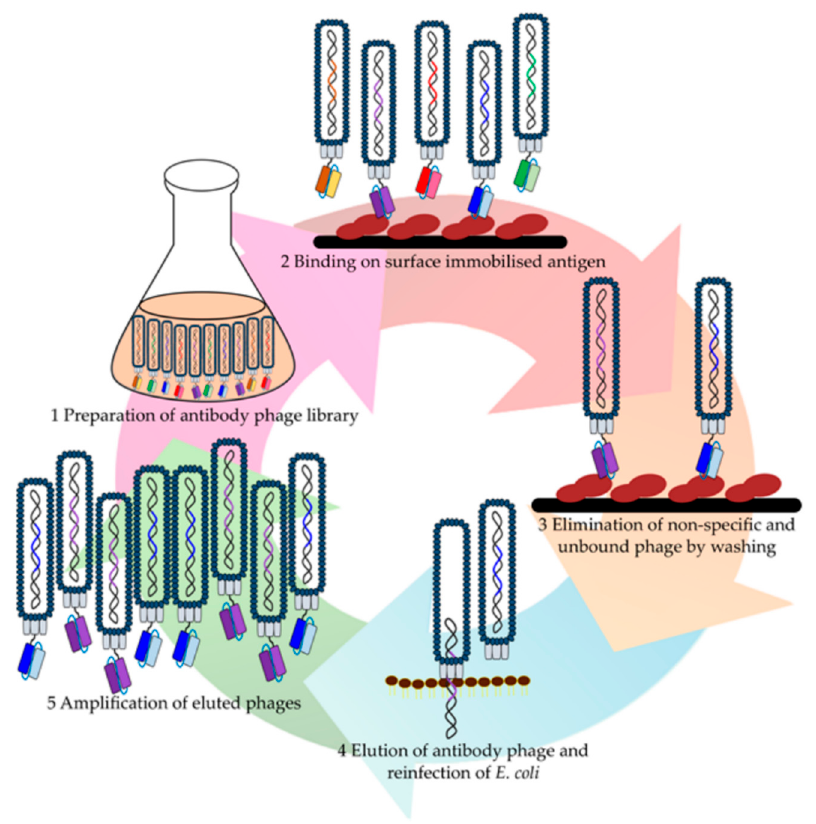
Figure 2. The biopanning process utilizing an antibody phage library against various target antigens. The process encompasses a few steps, including (1) preparation and (2) purification of the antibody phage library, and (3) repetitive binding, washing, (4) elution, rescue, and (5) amplification of the bound phages. The process is usually repeated three to five times to obtain an enrichment population.